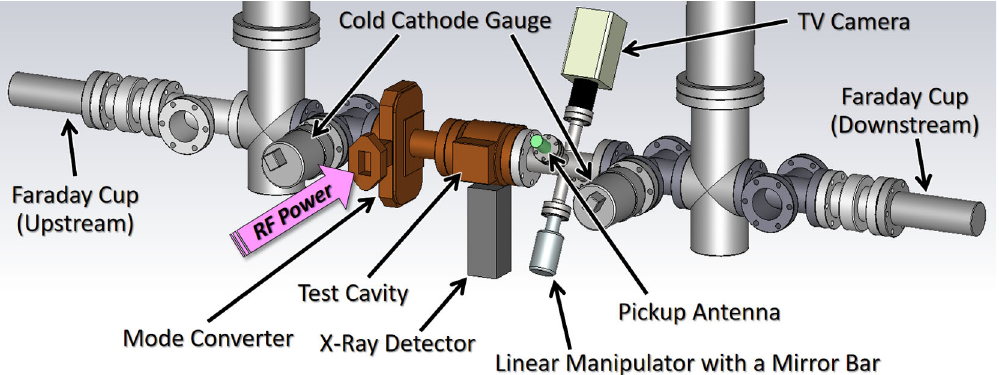
FIG. 9. Shield-B experimental